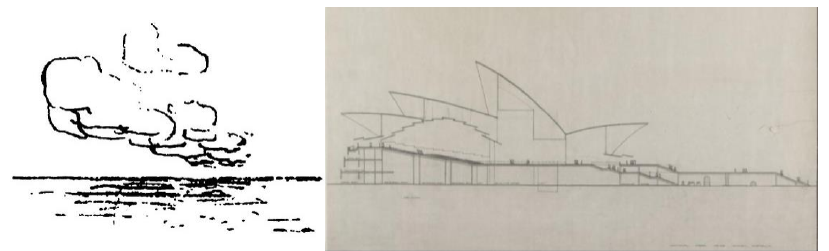
Figure 6. Left : Jørn Utzon sketch: platforms and plateaus (Jørn Utzon). Right : section from the competition drawings (Jørn Utzon; www.records.nsw.gov.au; last accessed 27 September 2021)